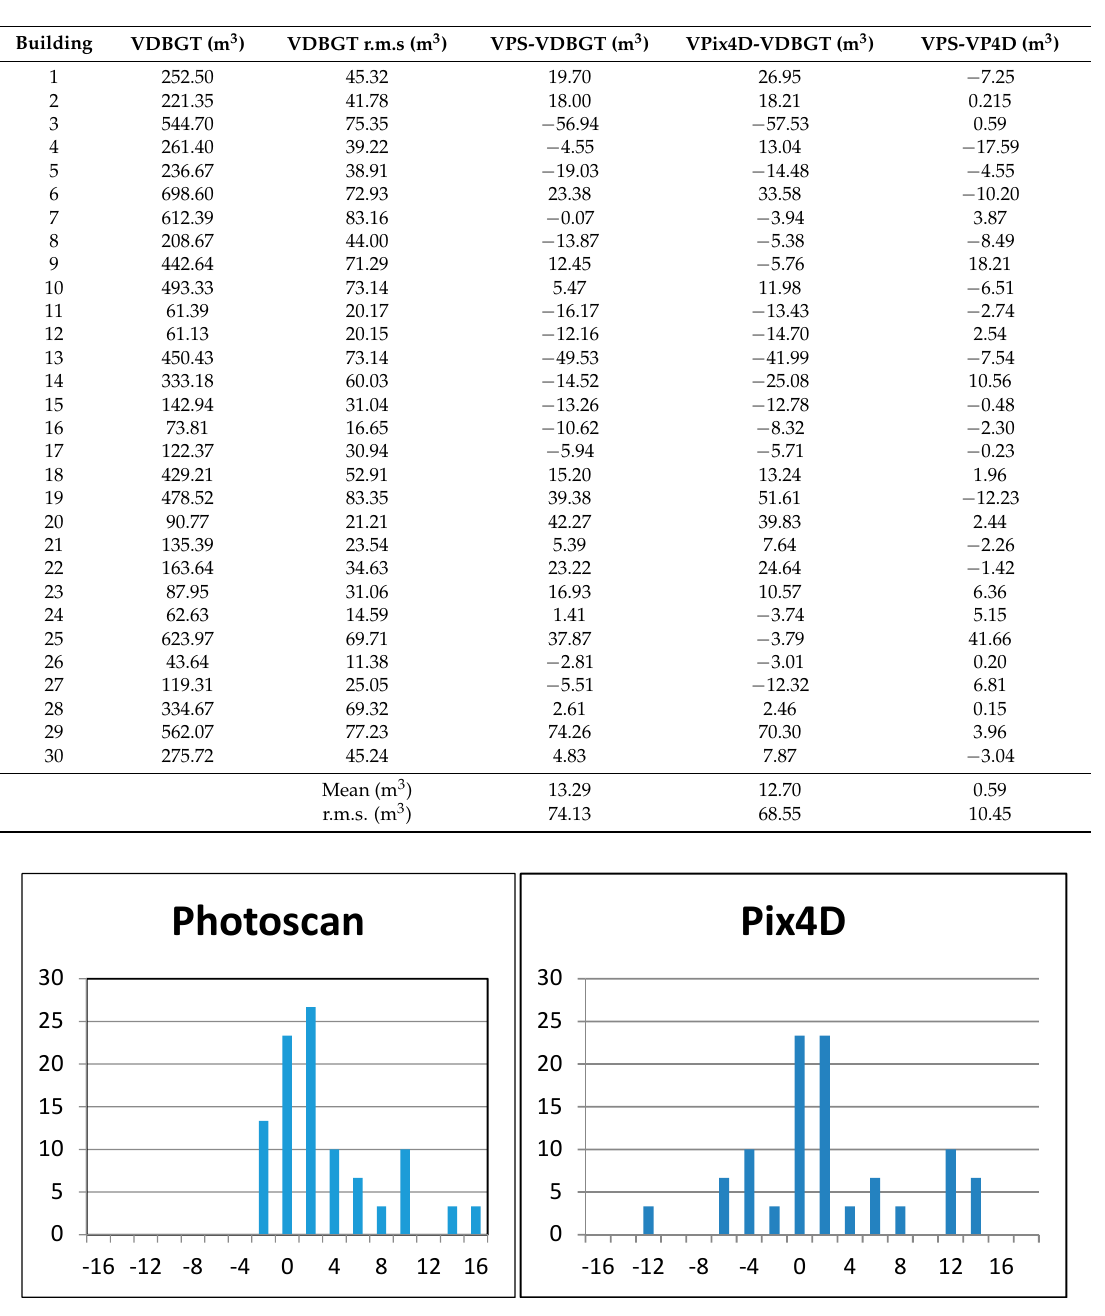
Table 7. Results of the volume measurements.